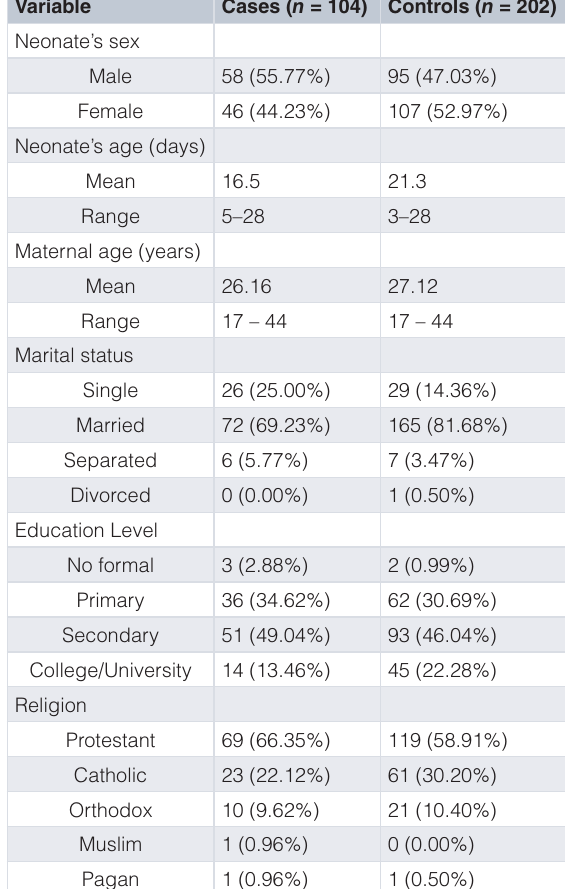
Table 2. Demographic characteristics of the respondents, KHC, Kenya, 2018 (n=306).